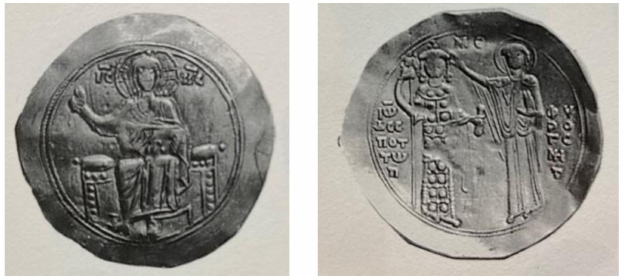
Figure 5. Second Indiction Hyperpyron Nomisma, 1122–1137; impression on gold; Amsterdam; 2.2 Peirce 1948 from Schulman i.30. Published at [15] (Ibid, pp. 261–274. The issues from the mint at Thessalonike have St Demetrios, the patron saint of the city, while those from Constantinople have St George. Images on Plates VIII and IX).